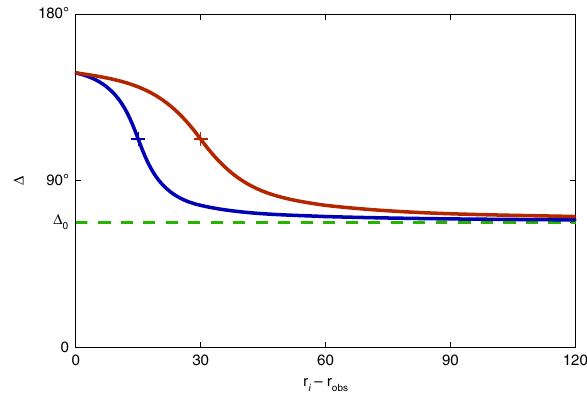
Fig. 7 Interaction rule for particles encountering an obstacle. Deviation angle Δ in dependence of the distance of an AP to the obstacle centre for obstacles with 15- μ m (blue) and 30- μ m (red) radius. Markers indicate the obstacle radii corresponding to the data shown in